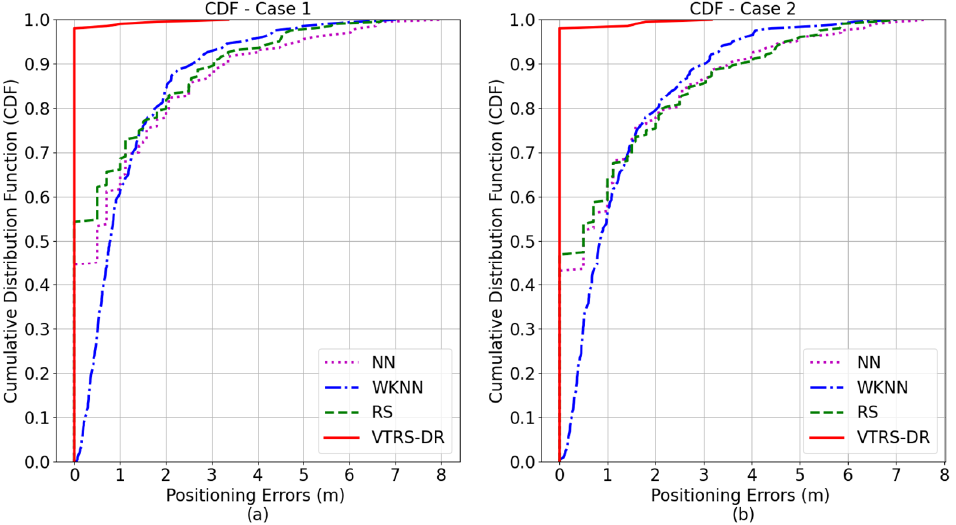
Figure 6. Cumulative position error distributions of the four methods in ( a ) Case 1 and ( b ) Case 2.